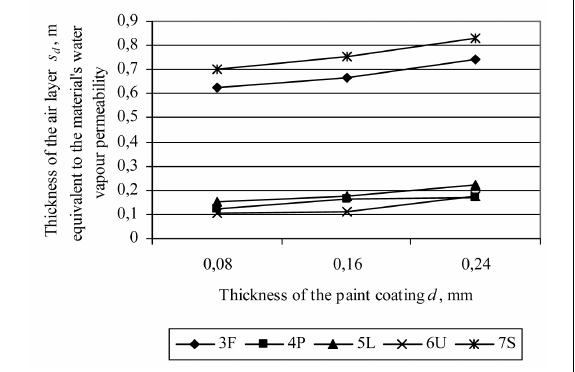
Fig 4. Dependence of the air layer thickness s equivalent to the d building material’s water vapour permeability on the thickness of the paint